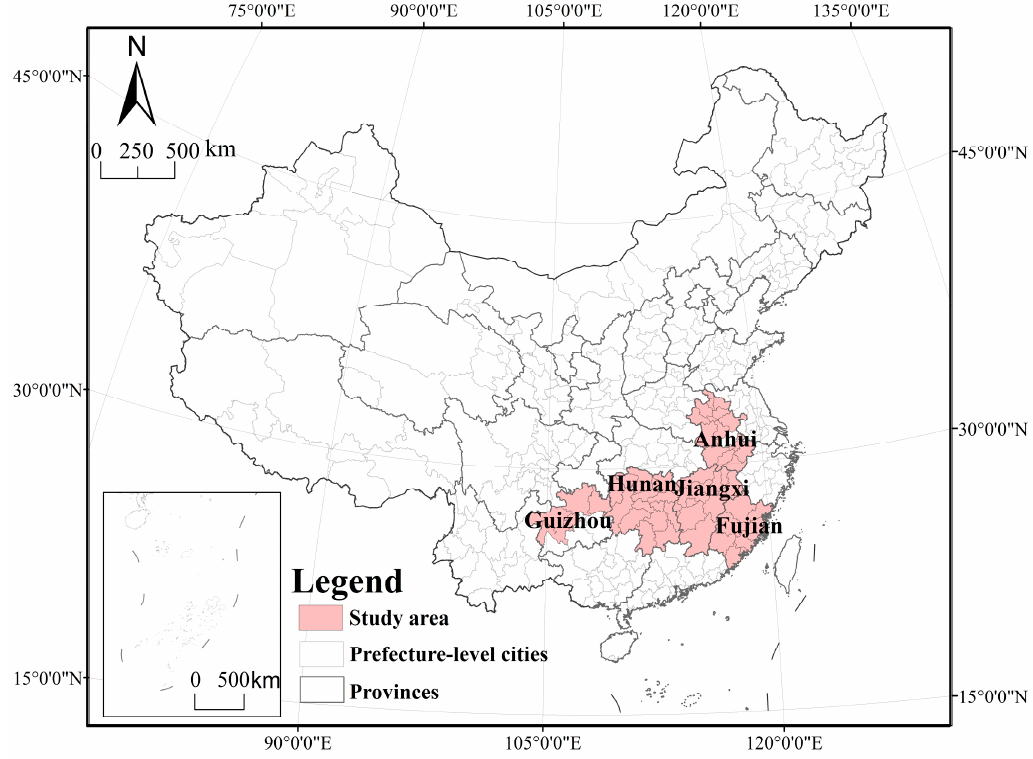
Figure 1. The geographical location of study area.